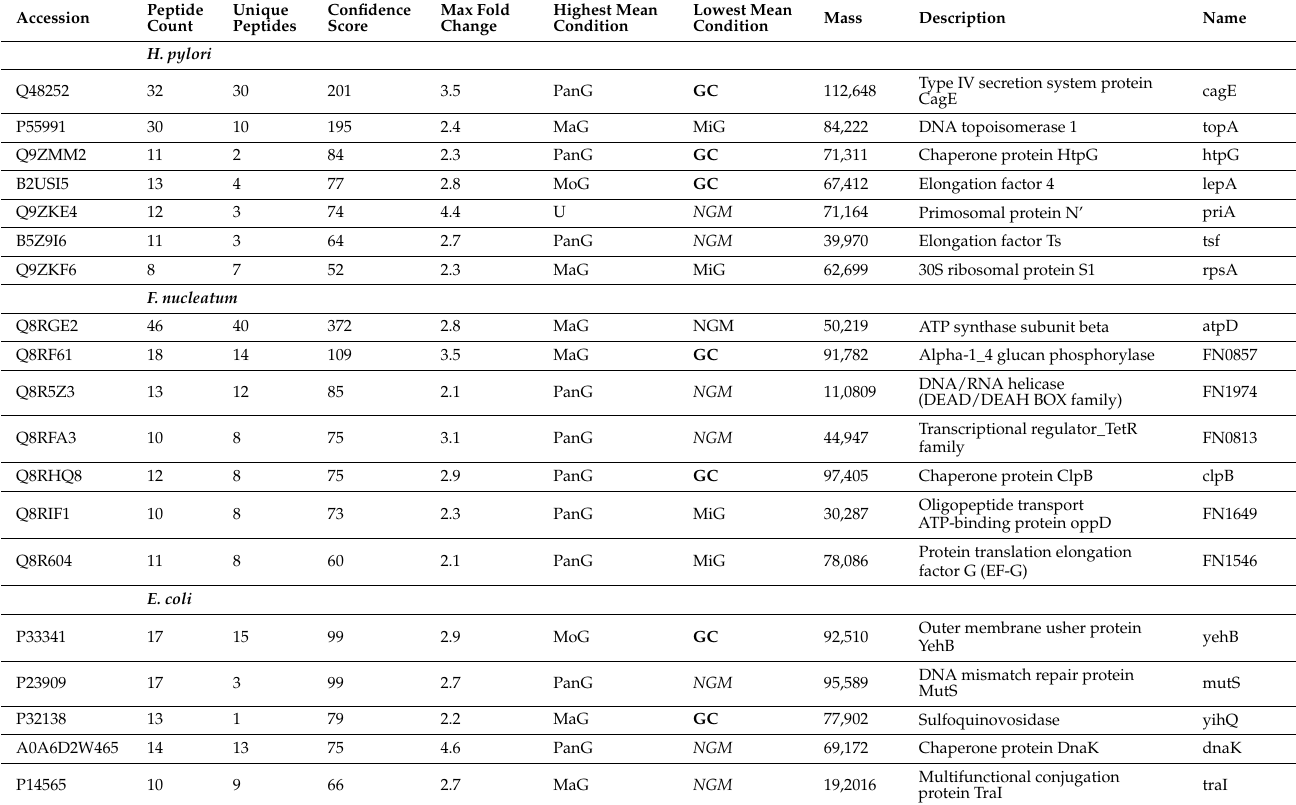
Table 1. Significantly changed bacterial proteins detected in stomach biopsies in the global analysis of all samples (Anova p < 0.02, confidence score > 50, fold change > 2, excluding proteins of no known function). For each MS data set, which was presented to Progenesis software, the cumulated ion intensities were used to calculate fold values for protein matches. The groups showing the highest and the lowest mean values are reported. In the case of multiple assignments of the same protein, only the best match is given. For details see Supplementary Table S1, for binary comparison Tables S2–S9. NGM has been italicized, and GC was marked in bold. Interestingly, the lowest mean condition is populated by NGM, MiG, and GC indicating more involvement of bacterial proteins in gastritis and ulcer.